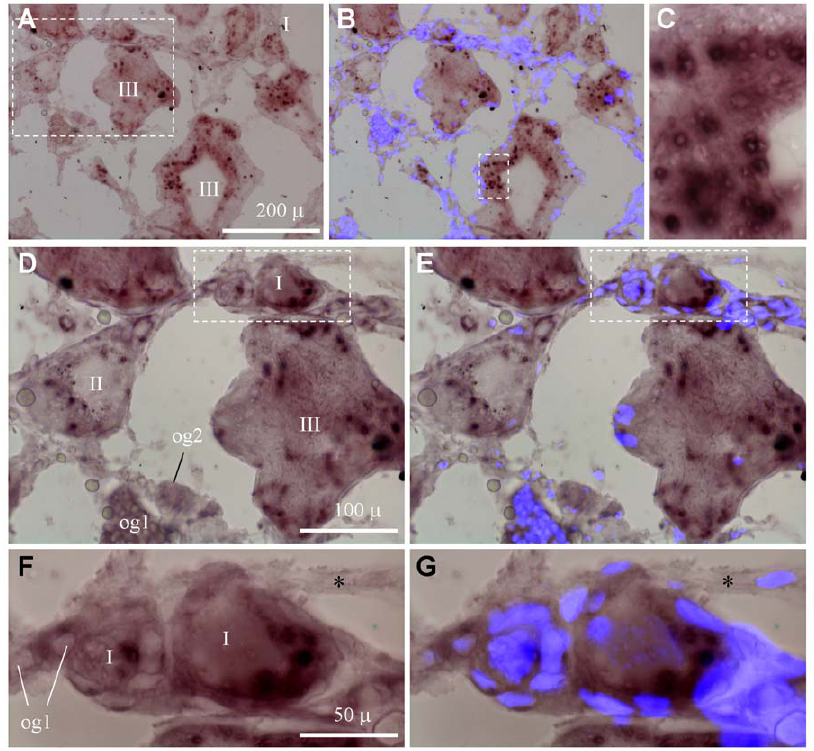
Figure 5. Expression of dazl RNA during oogenesis. (A and B) Lower magnification view showing different stages of oocytes (I to III) and dot- like structures of dazl RNA. (C) Larger magnification of the framed area in (B), highlighting hollow-like structure of dazl RNA. (D and E) Larger magnification of the framed area in (A), highlighting a cluster of undifferentiated oogonia (og1) and larger-sized, differentiating oogonia (og2). (F and G) Larger magnification of the framed area in (D and E), highlighting oogonia (og1) and early oocytes at stage I with residual nuclear staining by DAPI, and the absence of dazl signal in somatic cells (asterisk).